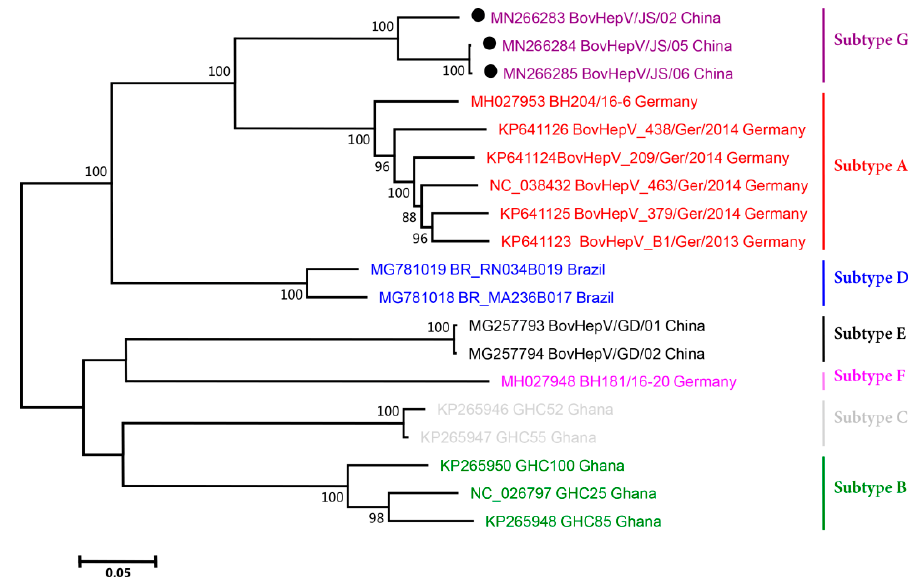
Figure 2. Phylogenetic analysis of BovHepV strains of subtypes A-G based on their polyprotein genes. The BovHepV strains identified in the present study (BovHepV/JS/02, BovHepV/JS/05, and BovHepV/JS/06) are indicated with circles. The detailed information for each BovHepV strain is shown, including the GenBank accession number, strain name, and country of origin.